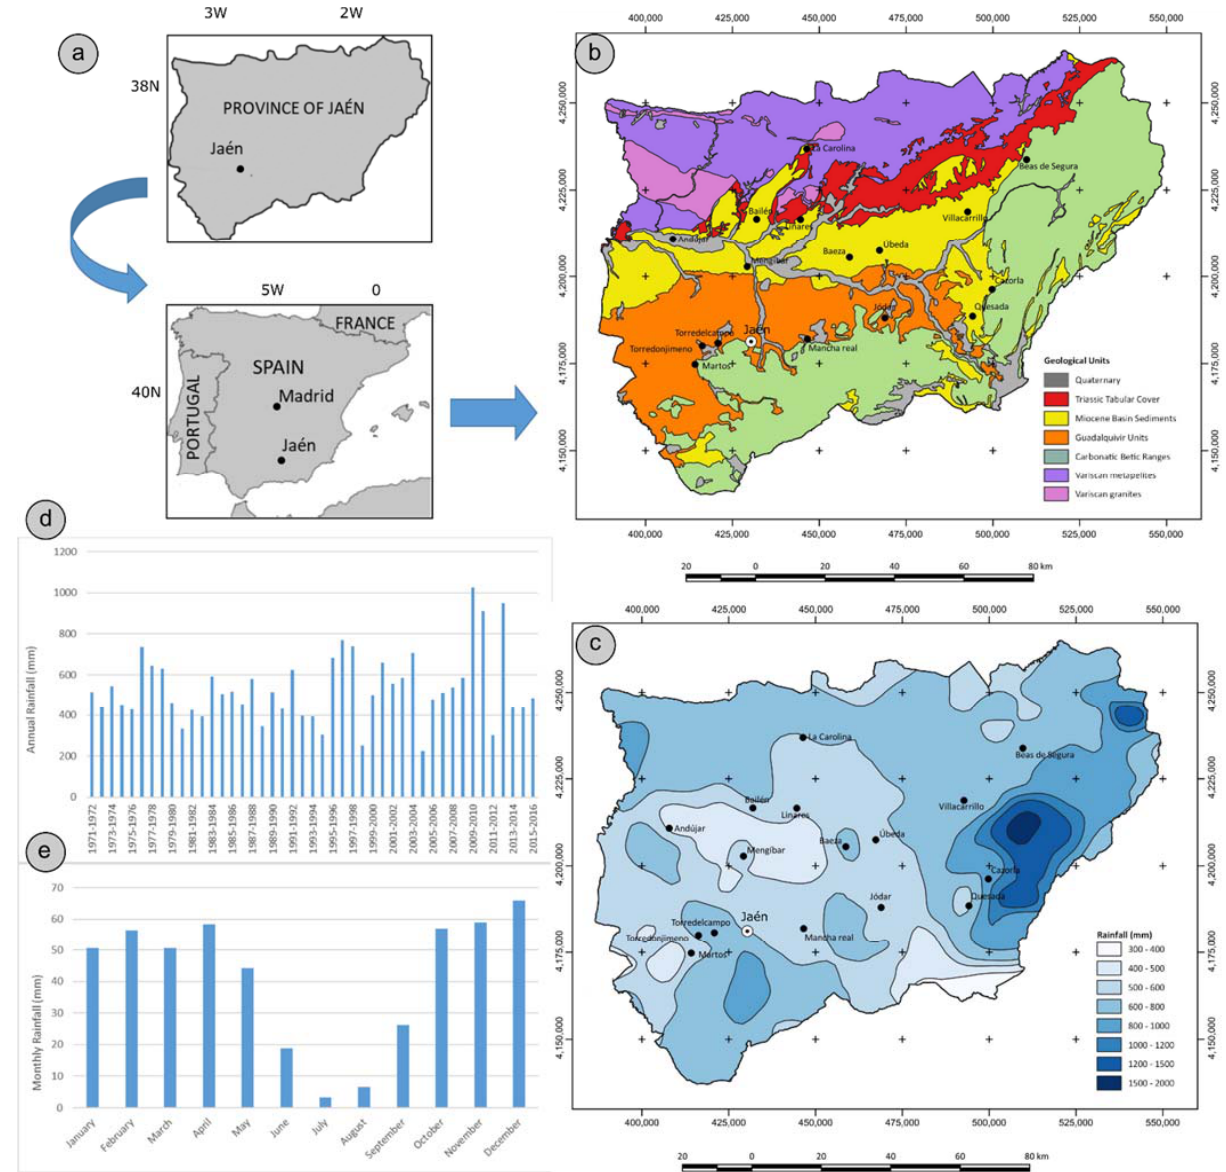
Figure 1. Location, geological setting, and climatic characterization: ( a ) location; ( b ) geological setting; ( c ) mean annual precipitation (MAP) of the province; ( d ) series of annual precipitation; and ( e ) monthly precipitation. The predominant land-use is agricultural crops; within them, olive grove constitutes